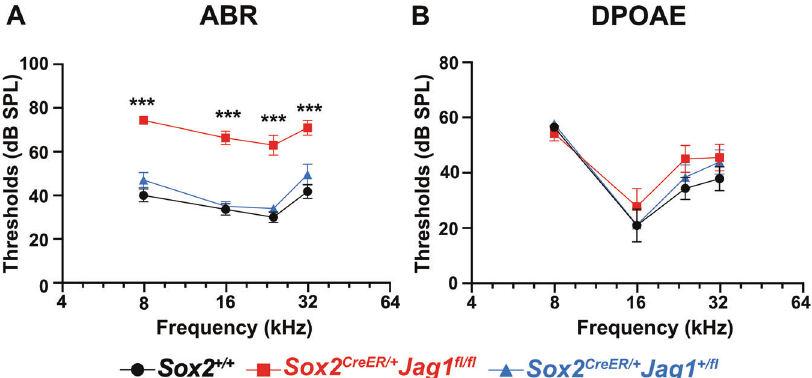
Fig. 2 Deletion of Jag1 in the maturing cochlea causes hearing loss. A , B Hearing test results at 6 weeks of age. Data expressed as mean ± SEM. A Average auditory brainstem response (ABR) thresholds for pure tone stimuli at 8, 16, 24, and 32 kHz showed signi fi cant increases in Sox2 CreER/ + Jag1 fl / fl mice. Signi fi cance (*) indicated Sox2 + / + vs. Sox2 CreER/ + Jag1 fl / fl ; two-way ANOVA Bonferroni adjusted; *** P ≤ 0.001. Sox2 + / + n = 11, Sox2 CreER/ + Jag1 fl / fl n = 12, Sox2 CreER/ + Jag1 + / fl n = 10. B Average distortion product otoacoustic emission (DPOAE) measurements showed no signi fi cant threshold differences between Sox2 CreER/ + Jag1 fl / fl and controls at all frequencies. Two-way ANOVA Bonferroni adjusted; n = 10 per